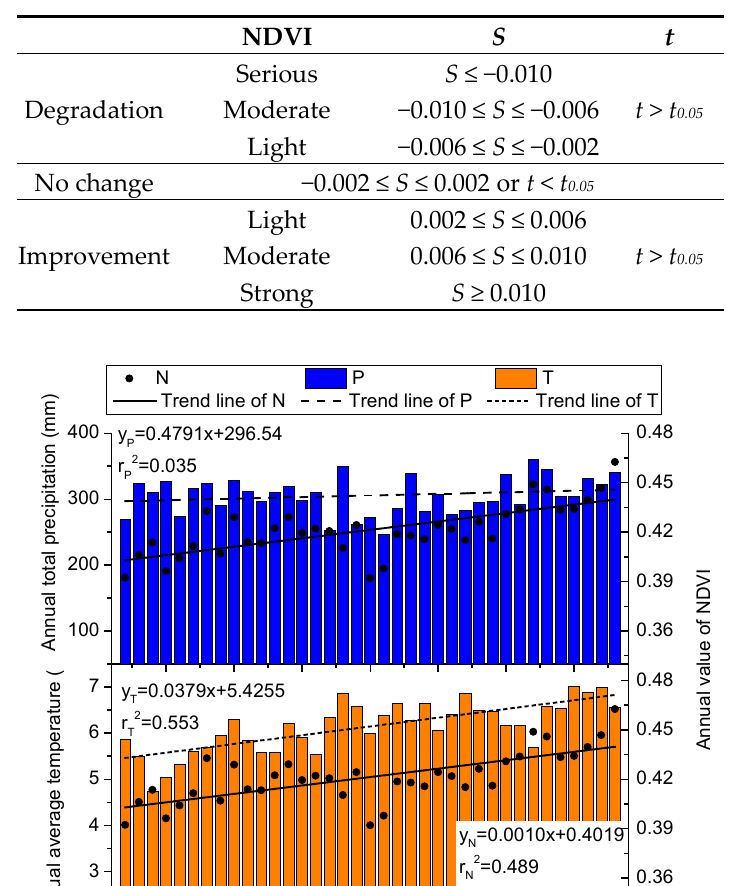
Table 2. Utilized statistical significance levels for NDVI change from 1980 to 2018 ( S is trend of NDVI change; t is the test statistic; t 0.05 is the critical value of the test statistic at a 0.05 significance level).